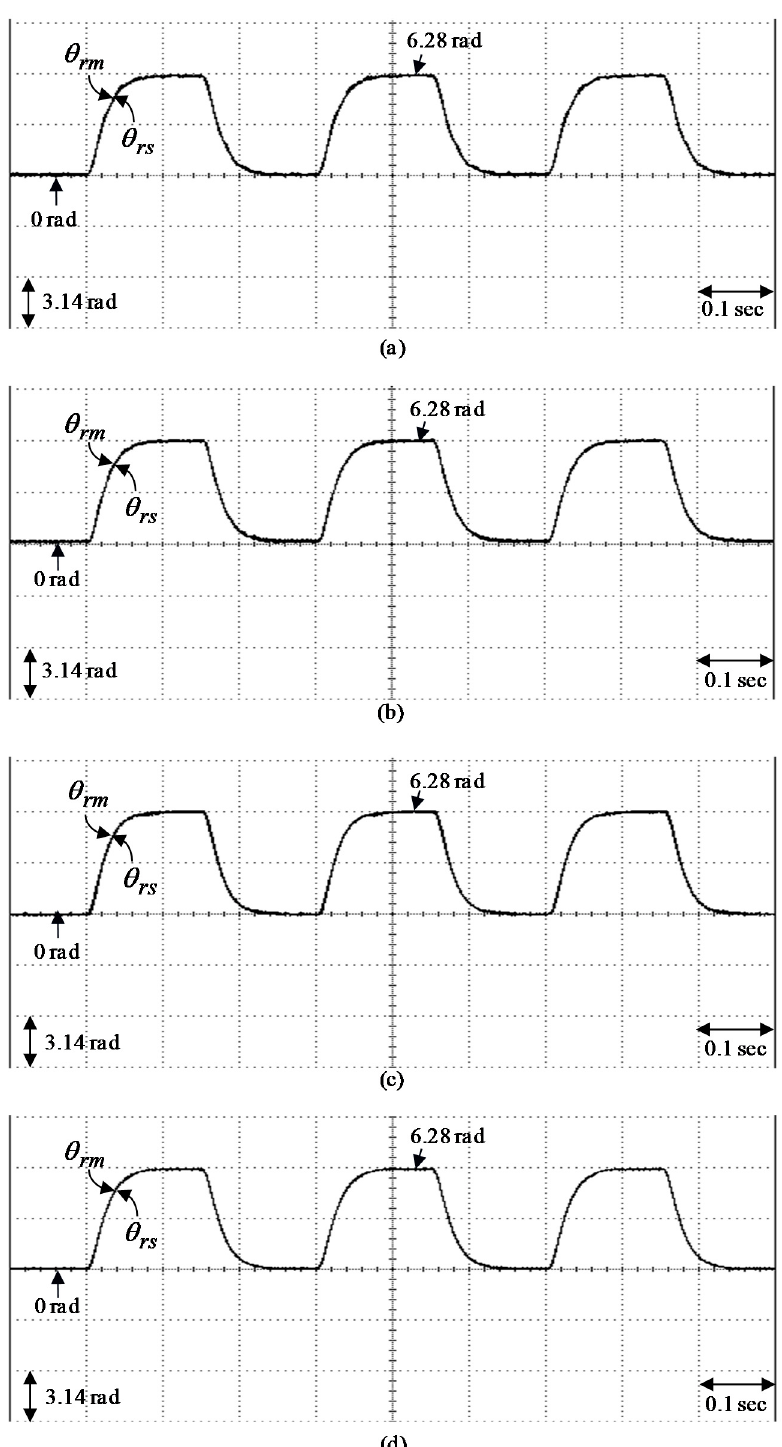
Figure 8. Experimental results of the rotor position response in Case R1 ( a ) by utilizing control system W1, ( b ) W2, ( c ) W3, and ( d ) W4.